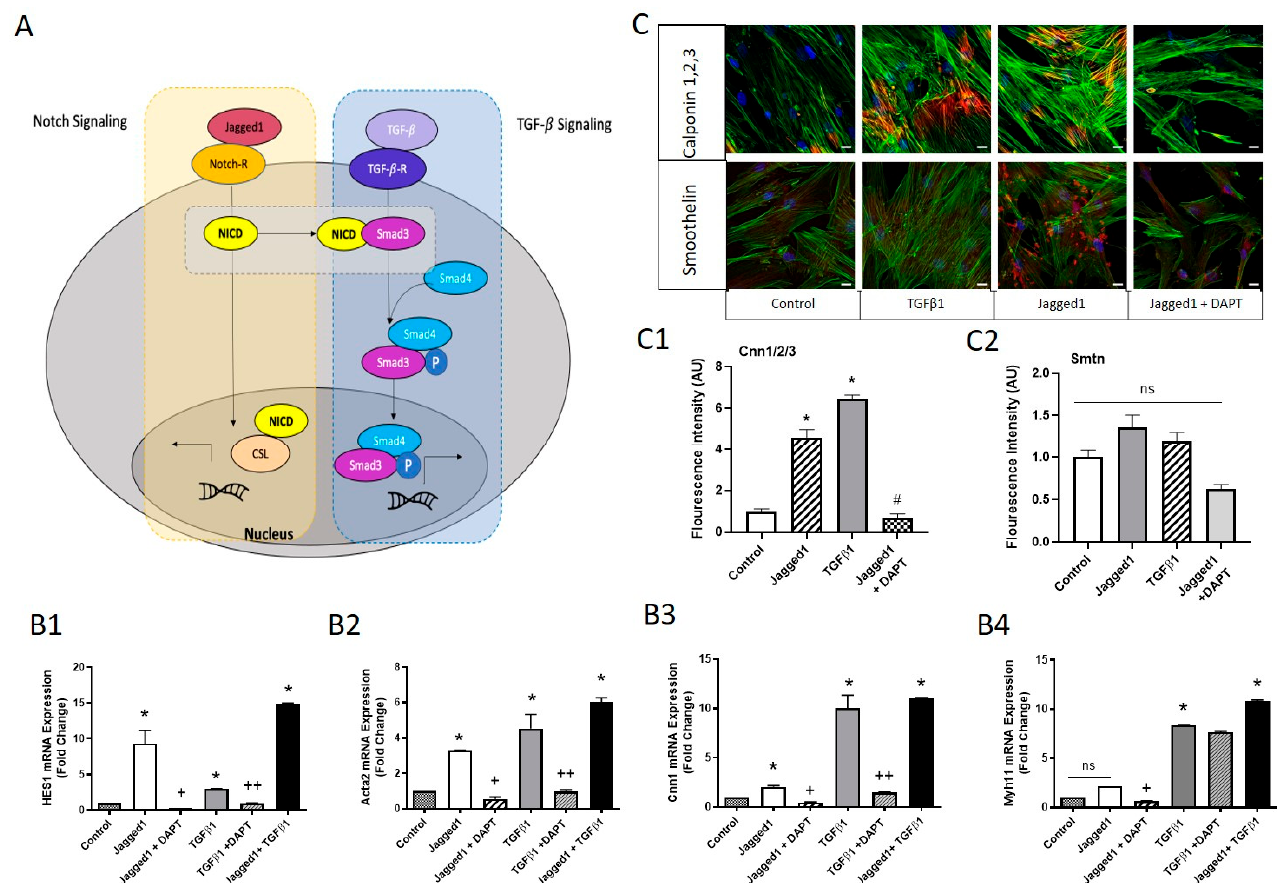
Figure 3. Convergence in Notch and TGF β signaling induced a mature contractile HCASMC phenotype. ( A ) Scheme for Notch and TGF β signaling convergence (proposed in the literature, Ref [40]). The NICD co-operatively interacts with Smad 2/3, an intracellular transducer of TGF β 1, influencing the regulation of downstream targets. ( B1 – B4 ) HCASMCs were treated for 3 days with 2.5 μ g/mL bead-bound Jagged1 or 2 ng/mL TGF β 1. Cells were also treated in combination with the Notch inhibitor DAPT (described in the methods) for possible signal convergence between Notch and TGF β 1. Gene expression levels of HES1, Acta2, Cnn1, and Myh11 are shown. Data are presented as the normalized mean ± SD, n = 6. * Indicates significance from the control cells, + indicates significant downregulation from the Jagged1 treatment group, and ++ indicates significant downregulation from the TGF β 1 treatment group at p < 0.05 (ns = not significant). ( C ) Immunofluorescence staining of HCASMCs treated with bead-bound Jagged1 and TGF β 1 stained for calponin 1,2,3 and smoothelin. Scale bar = 50 μ m. ( C1 , C2 ) Fluorescence intensity quantifications are presented as the normalized mean to the control ± SD. * indicates significance from the control, and # indicates significant downregulation from the Jagged1 treatment group. Control cells were untreated HCASMCs cultured in SmGM-2. ns indicates no statistical significance.